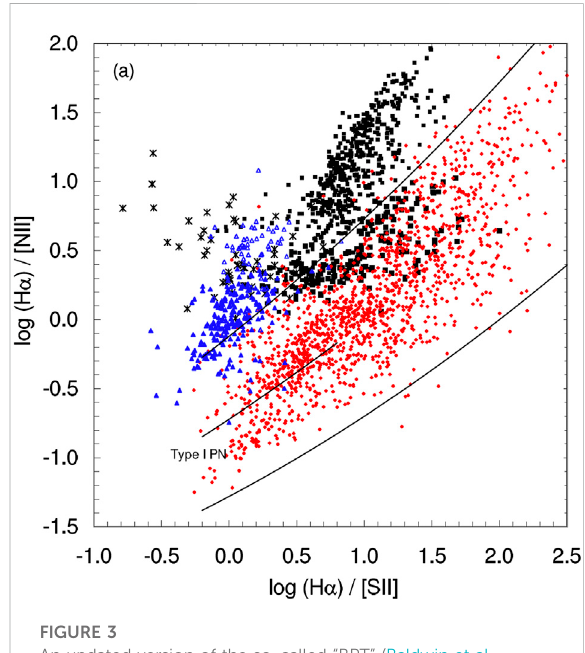
FIGURE 3 An updated version of the so-called “ BPT ” (Baldwin et al., 1981) diagnostic plot of log(H α )/[II] versus log (H α )/[SII] for emission line fl ux ratios of various object classes with emission spectra. The plot is reproduced from panel Figure.4a of Frew and Parker (2010). Here [NII] is the fl ux combination of the two red nitrogenlinesat6548and6584Åwhile[SII]referstothesumofthe two red sulphur line fl uxes at 6717 and 6731Å. The limits established empirically for where PN fall are shown by the two black-linetracksasestablishedbyFrewandParker(2010)fromour updated HASH data. We also plot the locii of Type I PN (as de fi ned byKingsburgh and Barlow(1994). Thereis clearly overlap between some classes so objects falling in these regions often need additional corroborating